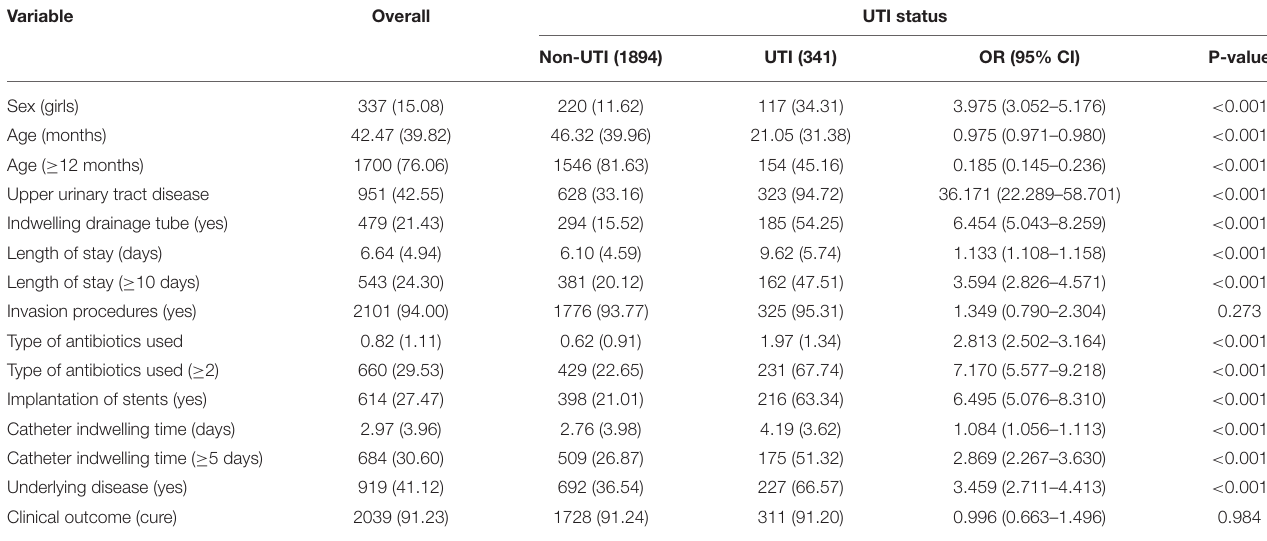
TABLE 1 | Baseline characteristics of participants.